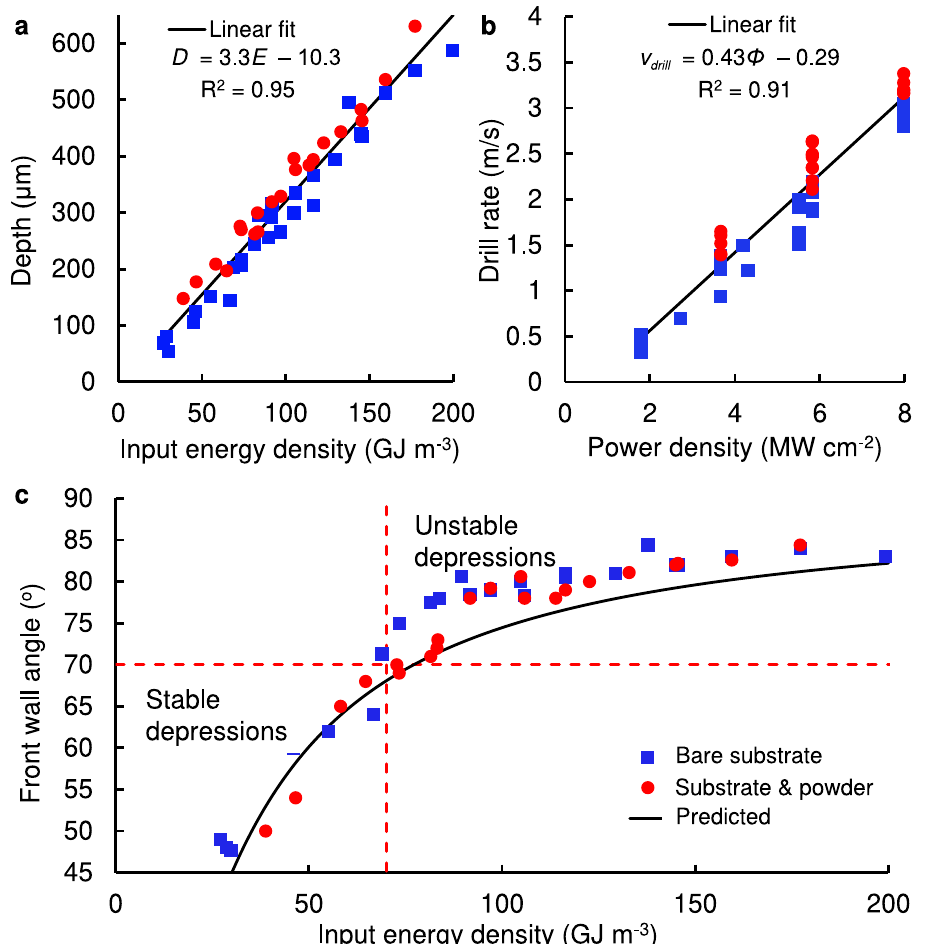
Fig. 6 Measurements of depression morphology during laser line scanning for experiments without and with powder. a Depression depth variation with input energy density. b Calculated drill rate based on experimental depth. c Measured and predicted front wall angle, according to tan θ = D/d . All three graphs use the same legend shown in ( c